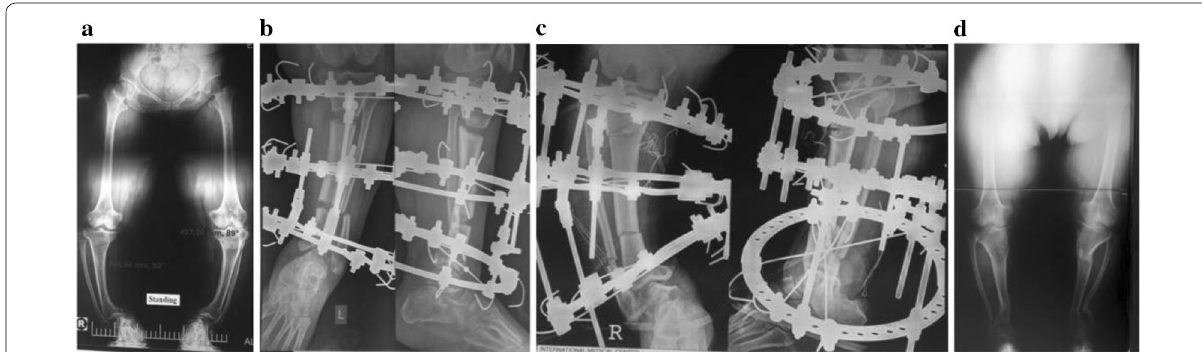
Fig. 5 a 53‑year‑old female with achondroplasia with knee and ankle deformities. b Bifocal corticotomy and application of Ilizarov Frame on the left side. c Bifocal corticotomy and application of Ilizarov Frame on the right side. d After fixator